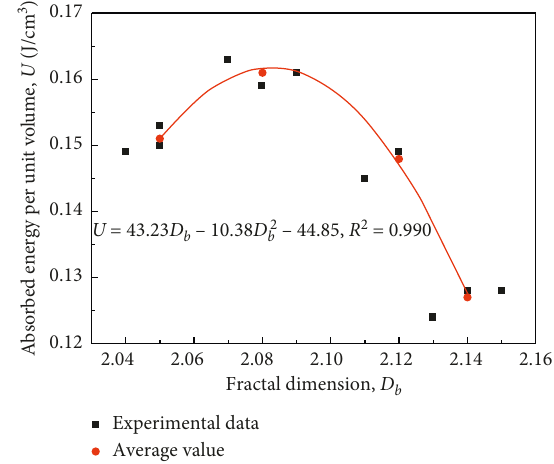
Figure 14: Relationship between absorbed energy per unit volume and fractal